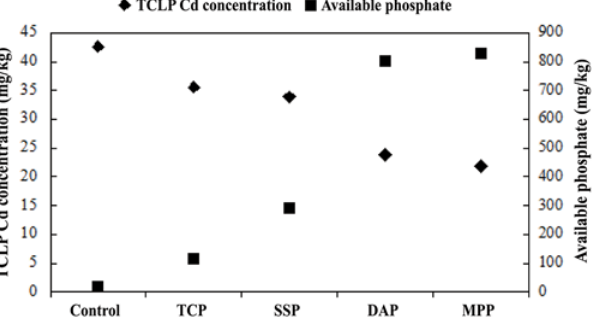
Fig 1. TCLP extractable Cd concentration and soil available phosphate in the control and phosphate treated soils after 50 d immobilization.